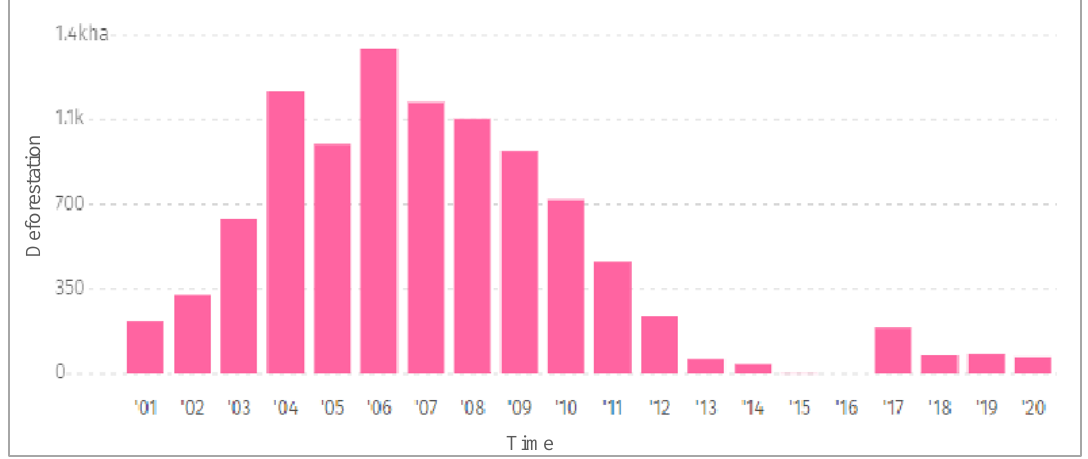
Figure 5. Deforestation in Pakistan 2001-2020 (Global forest